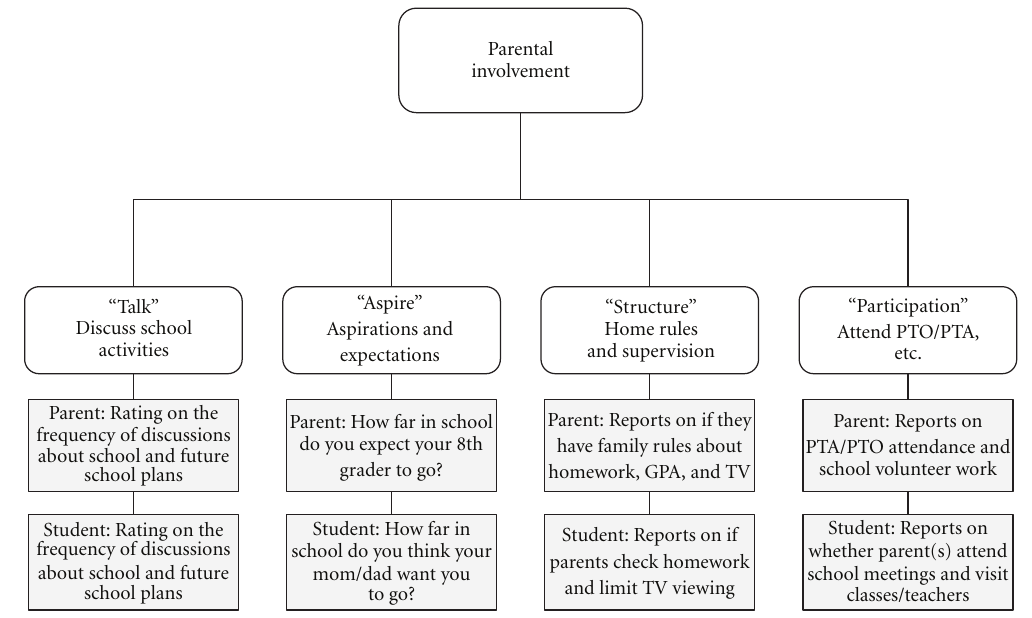
Figure 3: Original four variables underlying the PI construct in the Keith et al. [11] study. Note: adapted from “Does parental involvement a ff ect eighth-grade student achievement? Structural analysis of national data,” by T. Z. Keith, P. B. Keith, G. C. Troutman, P. G. Bickley, P. S. Trivette, and K. Singh, 1993, School Psychology Review , 22 (3), pp. 483,